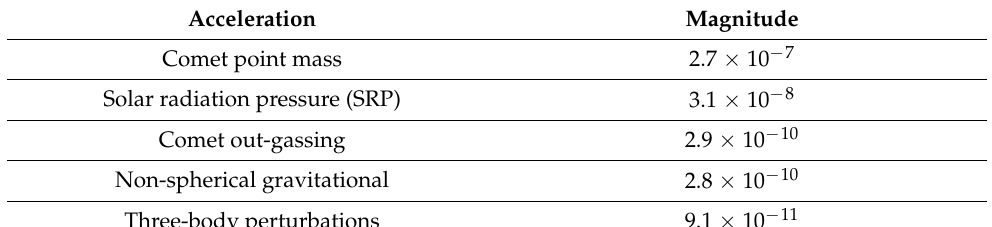
Table 5. Accelerations acting on the Rosetta S/C in the J2000 frame (m/s 2 ).